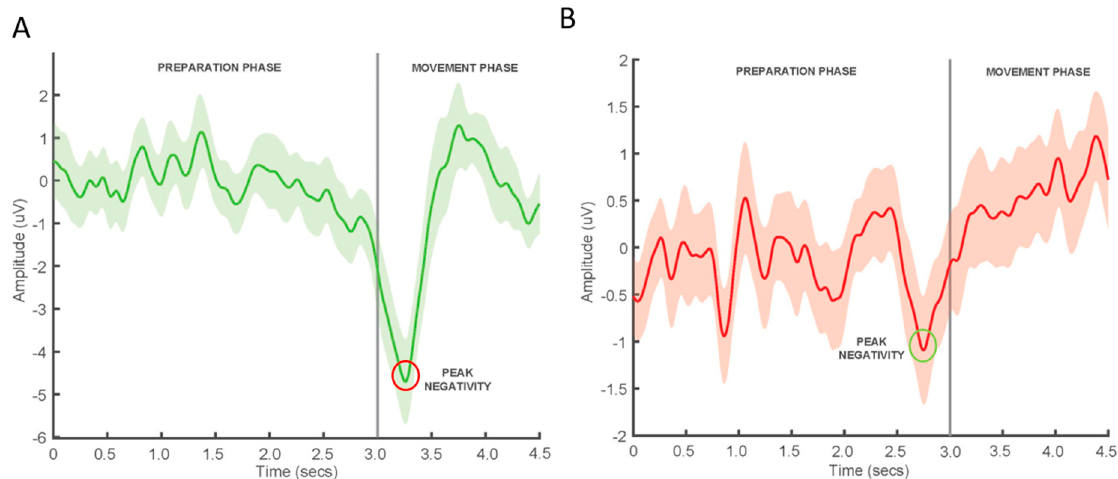
Figure 3. Average MRCPs with 95% confidence intervals obtained from one participant ( A ) performing voluntary ankle dorsiflexion and ( B ) performing imagined ankle dorsiflexion. The vertical line at the 3-s mark corresponds to the visual cue to move.